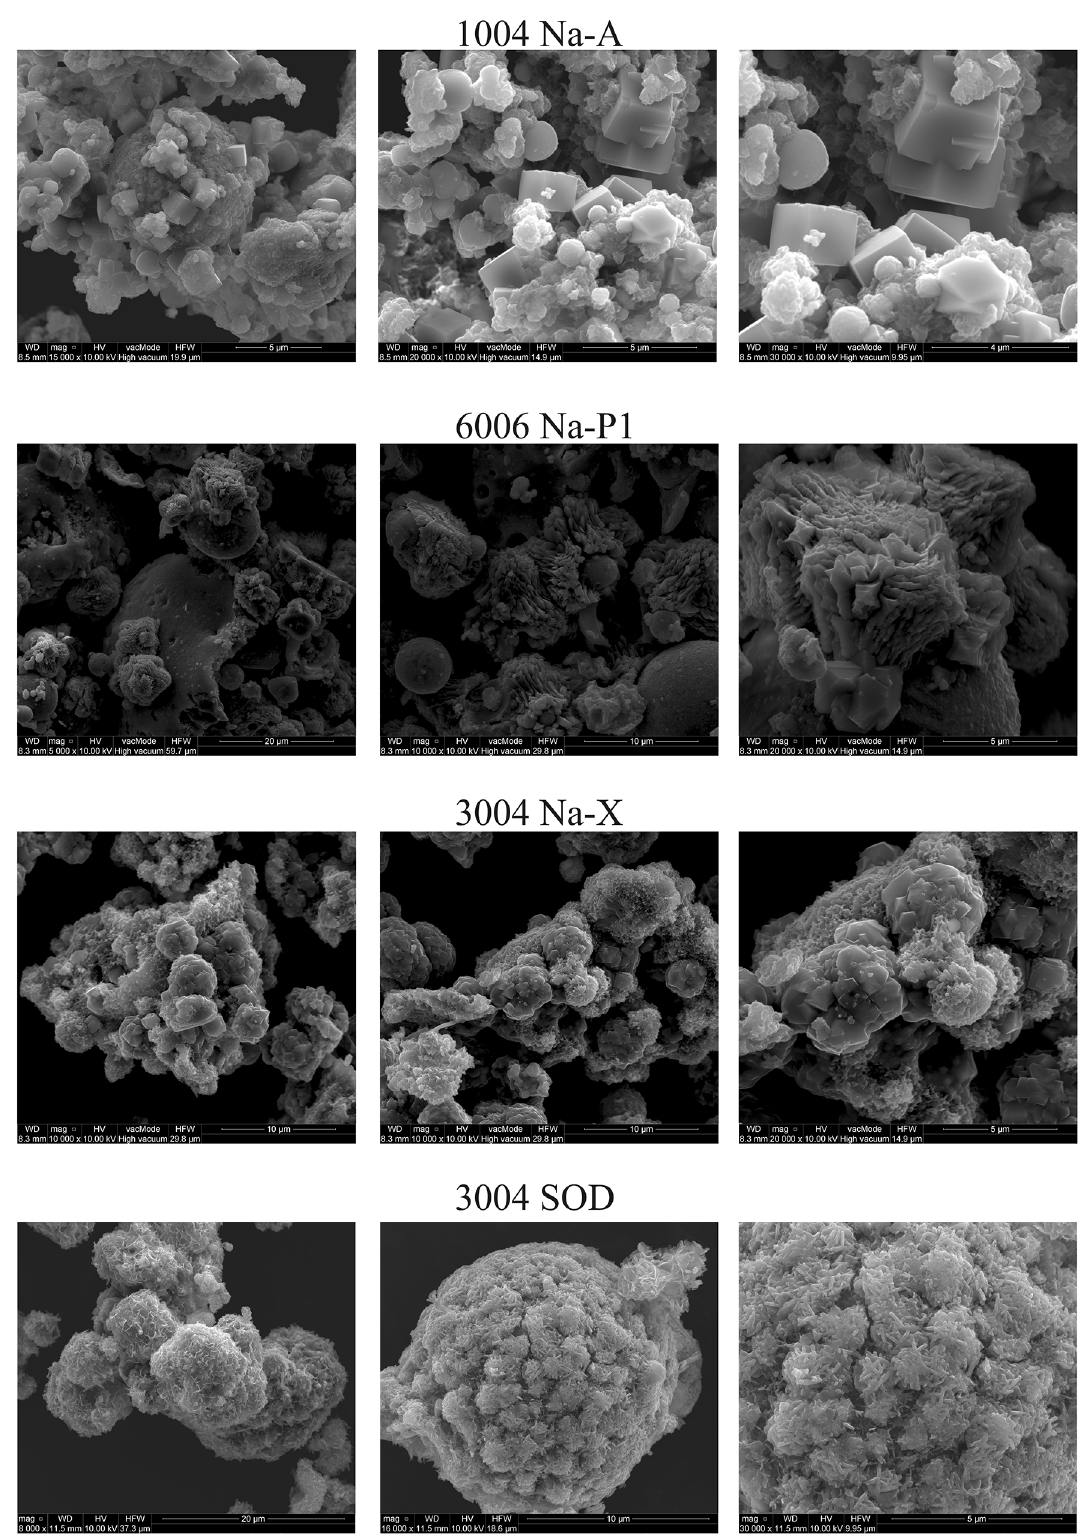
Fig. 7 SEM micrographs of selected best synthesis of Na-A, Na-P1, Na-X and